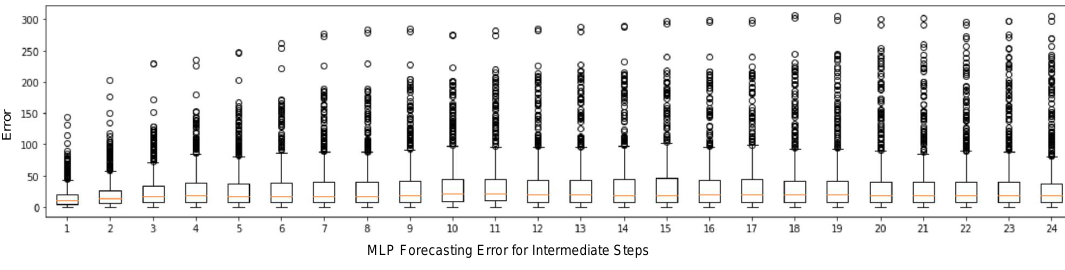
Figure 15. The distribution of absolute error for MLP neural network in multi-step forecasting scenario. The absolute error increases naturally with the number of steps forward to forecast.